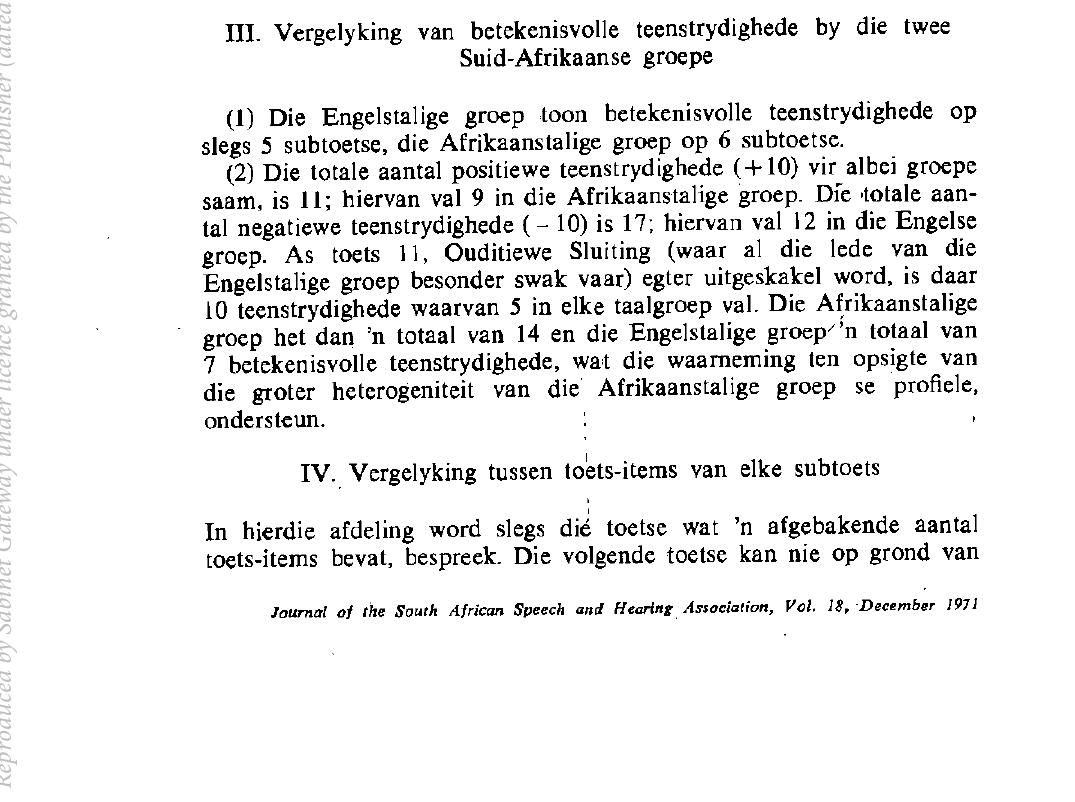
Tabel II—Verskille tussen subtoeis-skaalpunt en